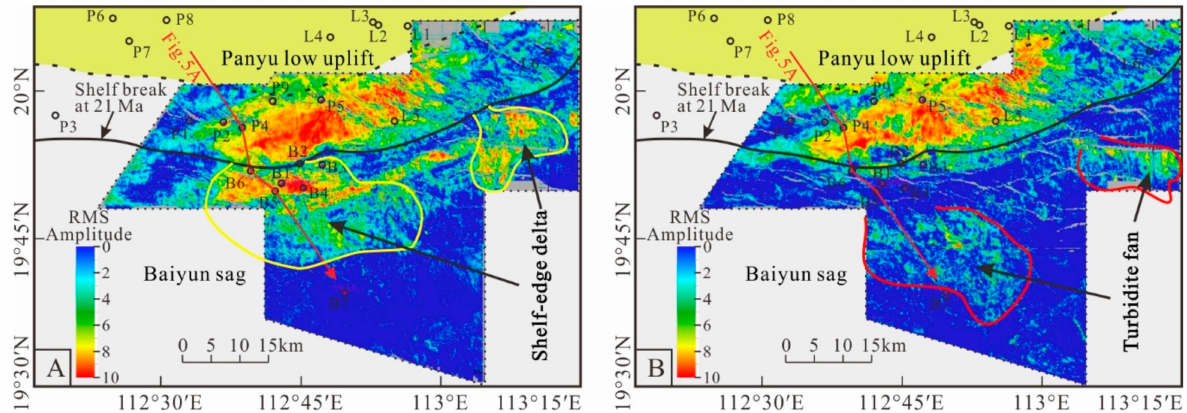
Figure 6. Distribution range of the shelf-edge delta ( A ) and the turbidite fan ( B ): ( A ) The yellow coil is the development range of the shelf-edge delta. Root mean square amplitude attribute extracted 30 ms downward from the 21 Ma, which is the upper interface of falling stage systems tract. ( B ) The red coil is the development range of the turbidite fan. Root mean square amplitude attribute extracted 30 ms upward from the basal surface of forced